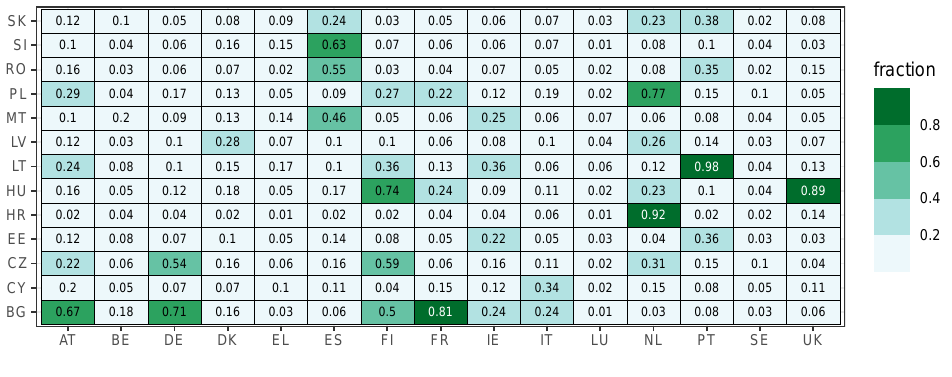
Figure 3. Fraction of nonzero regression